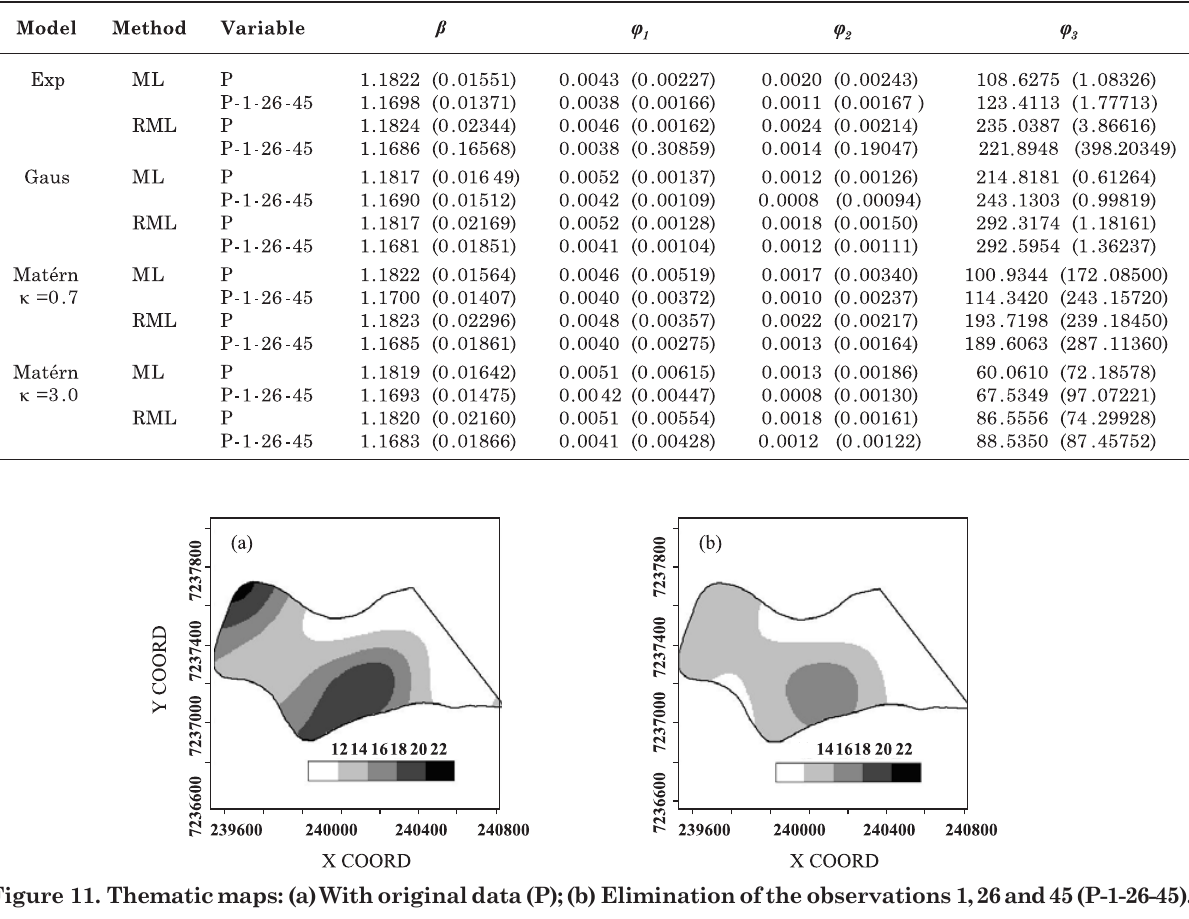
Table 3. Estimates of maximum likelihood (ML) and restricted maximum likelihood (RML) for βββββ , ϕϕϕϕϕ ϕϕϕϕϕ